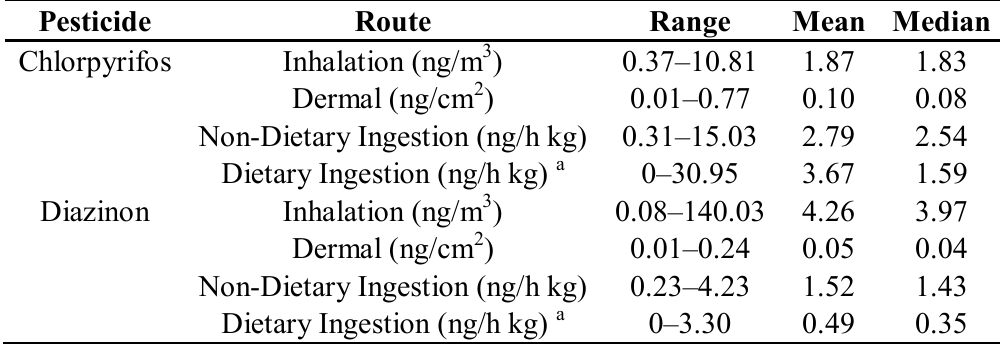
Table 1. Farmworker children’s route-specific exposure estimates